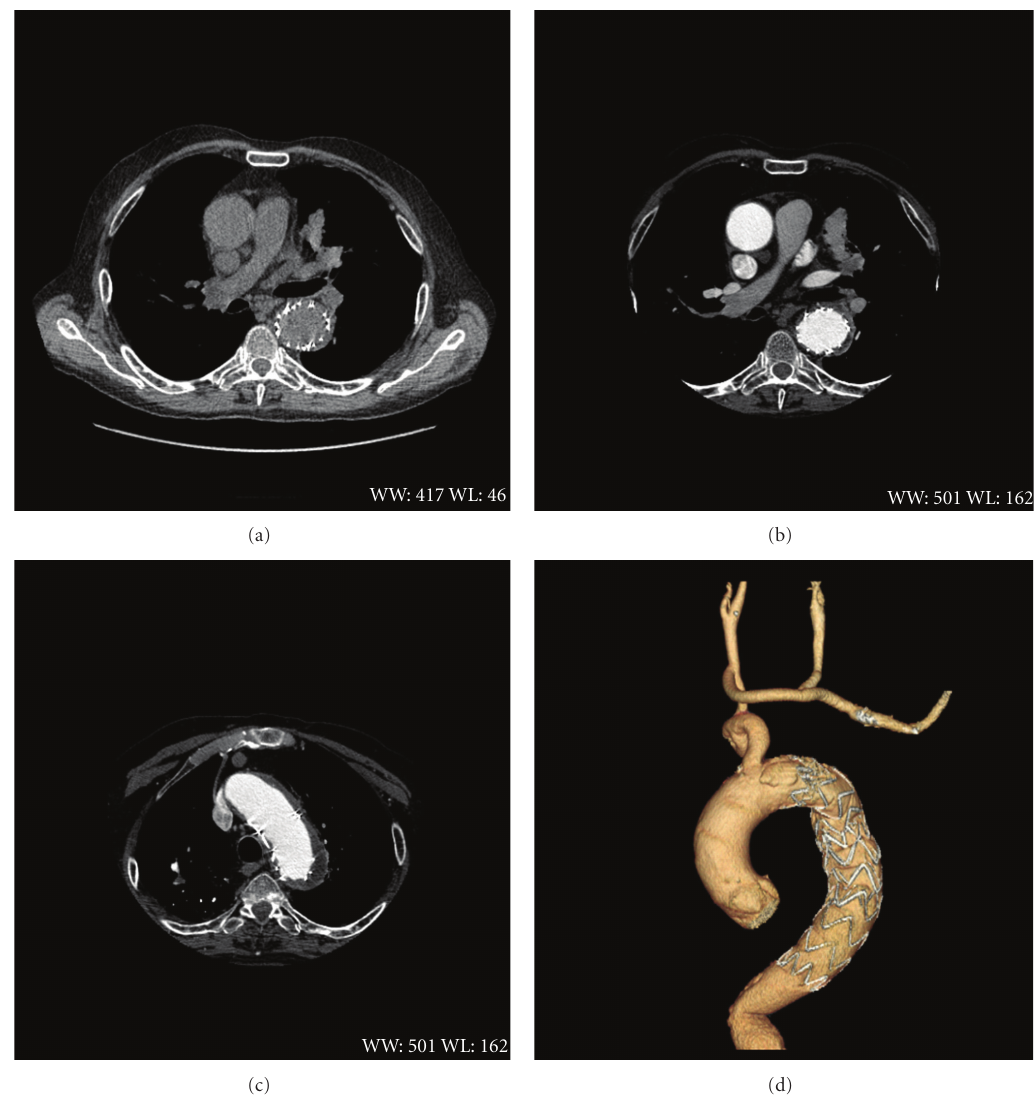
Figure 3: Computed tomographic angiogram at postoperative four weeks later. ((a) and (b)) No observation of intramural hematoma. (c) No observation of true and false lumen. (d) Reconstructed view of the aorta and